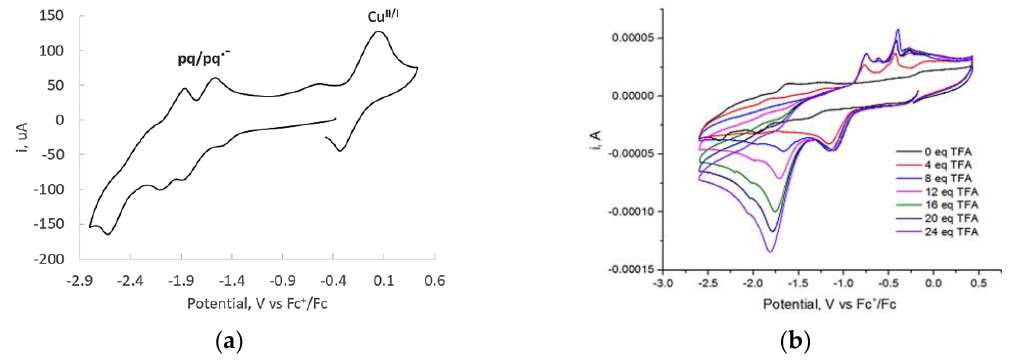
Figure 3. ( a ) Cyclic voltammogram (CV) of complex [1] + (1mM) in DMF solution of n -Bu4NPF6 (0.1 M) on a glassy carbon electrode at a scan rate of 0.1 V s-1 ( b ) CVs of [1] + 1 mM in DMF (0.1 M Bu4NPF6) with increasing equivalents of